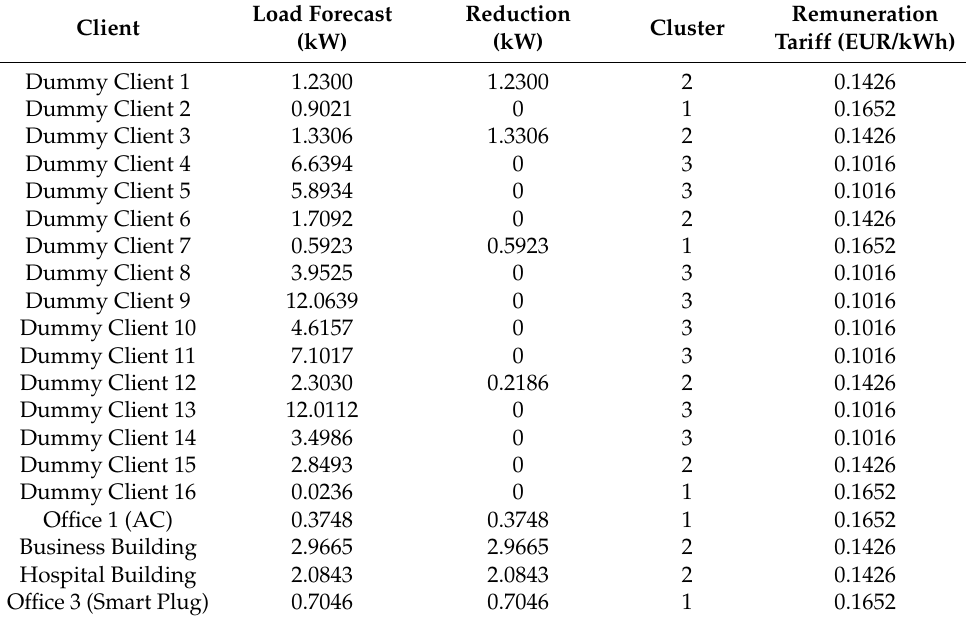
Table 2. Demand Flexibility Service results.